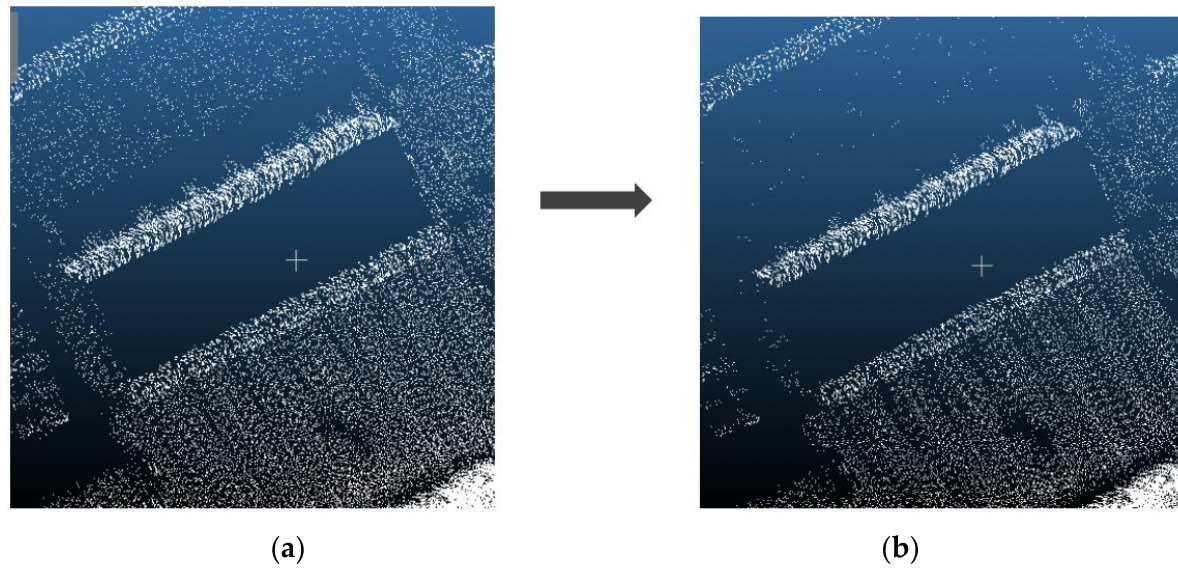
Figure 15. Noise filtering process with tool selection and removal of isolated points. ( a ) Point cloud of the surveyed area before the noise filtering process; ( b ) point cloud of the surveyed area after the process.